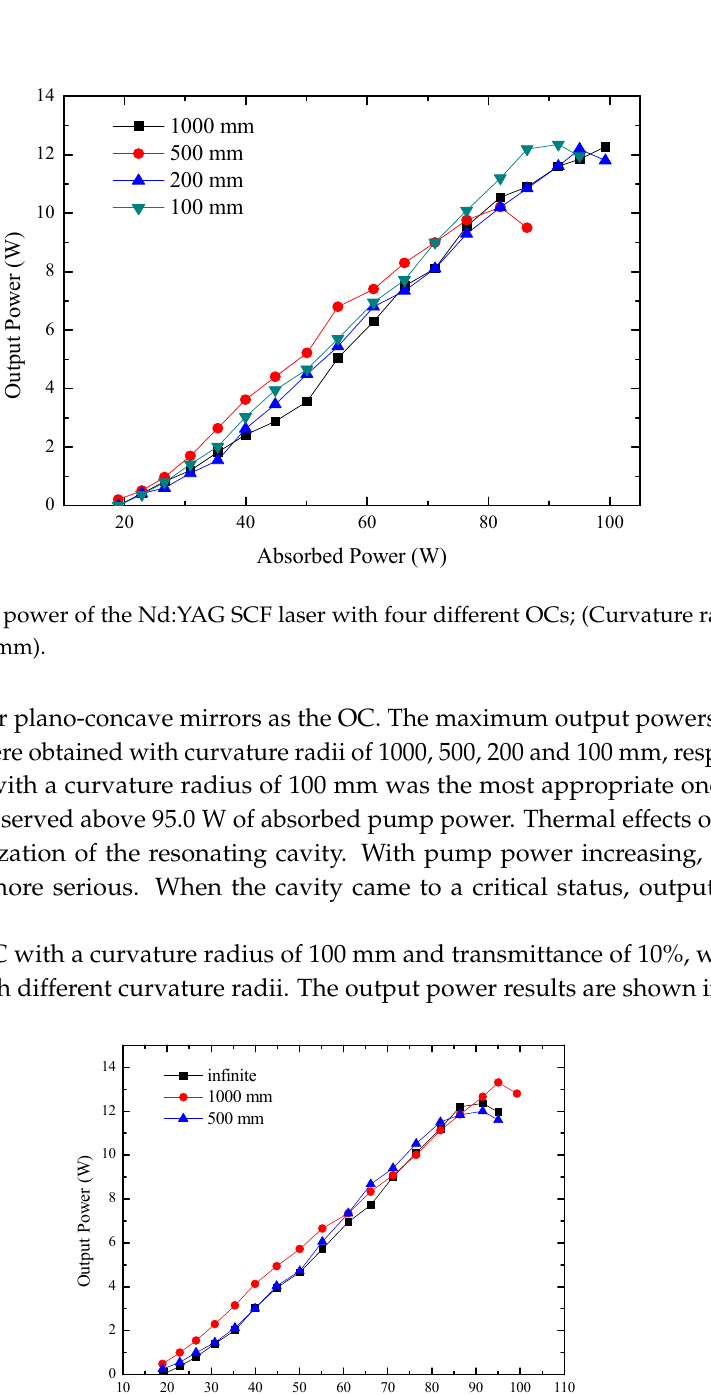
Figure 5. Output power of the Nd:YAG SCF laser with three different rear mirrors; (Curvature radius: infinite, 1000 and 500 mm).